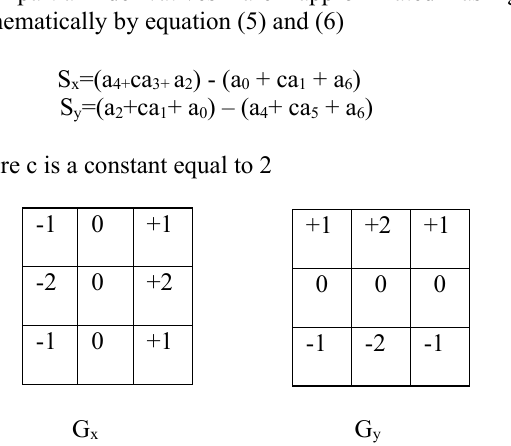
Figure 3. Algorithm of Canny Edge Detection Segmentation